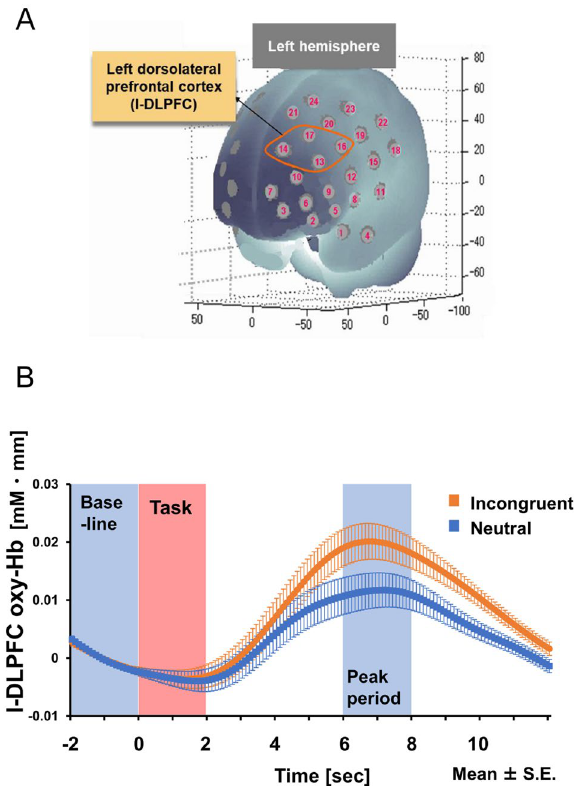
Figure 6. ( A ) The spatial profiles of fNIRS channels and ROI segmentation. ( B ) Time course of l-DLPFC oxy-Hb change (average of all Pre sessions). From − 2 to 0 is the baseline period, from 0 to 2 is the Task period, and from 6 to 8 is the peak period. The differences between incongruent trials (orange line) and neutral trials (blue line) at the peak period were evaluated as Stroop oxy-Hb interference